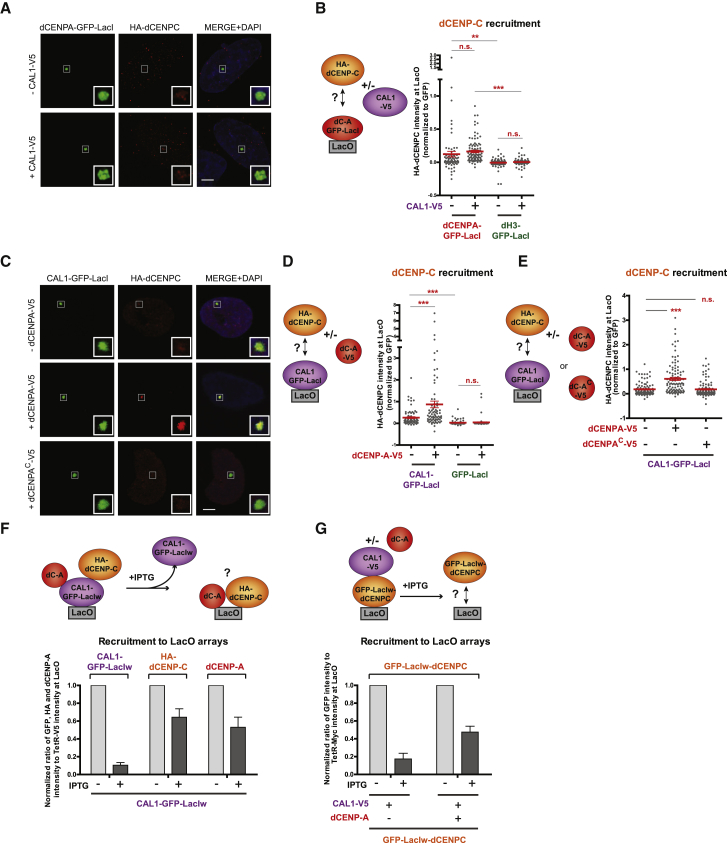
dCENP-C Is Loaded by CAL1 to LacO Arrays Containing dCENP-A Nucleosomes(A) Representative IF images of HA-dCENP-C recruitment to the LacO arrays by dCENP-A-GFP-LacI, +/− CAL1-V5, in U2OS cells.(B) Experimental scheme and quantitation of normalized HA-dCENP-C mean intensity at LacO upon tethering of GFP-LacI-tagged dCENP-A- or dH3, +/− CAL1-V5 (for % cells see Figure S5A).(C) Representative IF images of HA-dCENP-C recruitment to the LacO arrays by CAL1-GFP-LacI, +/− dCENP-A-V5 or dCENP-AC-V5, in U2OS cells.(D) Experimental scheme and quantitation of normalized HA-dCENP-C mean intensity at LacO upon tethering of CAL1-GFP-LacI or GFP-LacI, +/− dCENP-A-V5 (for % cells see Figure S5B).(E) Experimental scheme and quantitation of normalized HA-dCENP-C mean intensity at LacO upon tethering of CAL1-GFP-LacI, +/− V5-tagged dCENP-A or dCENP-AC.(F) Experimental scheme and quantitation of normalized CAL1-GFP-LacIw, HA-dCENP-C, and dCENP-A mean intensities at LacO, +/− IPTG treatment.(G) Experimental scheme and quantitation of normalized GFP-LacIw-dCENP-C mean intensity at LacO in the presence of CAL1-V5, +/− dCENP-A and +/− IPTG treatment.Scale bar, 5 μm. Insets show magnification of the boxed regions. Error bars show SEM (∗∗p < 0.01; ∗∗∗p < 0.001; n.s., not significant).See also Figure S5.